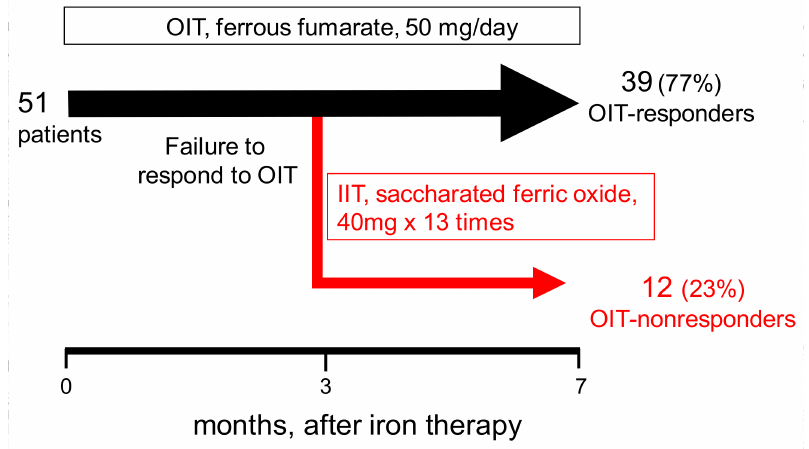
Figure 1. Protocol of iron therapy. Fifty-one consecutive hemodialysis (HD) patients with iron deficiency anemia (IDA) and minor inflammation were first treated with oral ferrous fumarate (50 mg/day). At 3 months after oral iron therapy (OIT), the patients were classified into two groups; OIT-responders and OIT-nonresponders. OIT was continued in 39 OIT-responders for another 4 months. OIT was switched to intravenous iron therapy (IIT; saccharated ferric oxide: 40 mg × 13 times